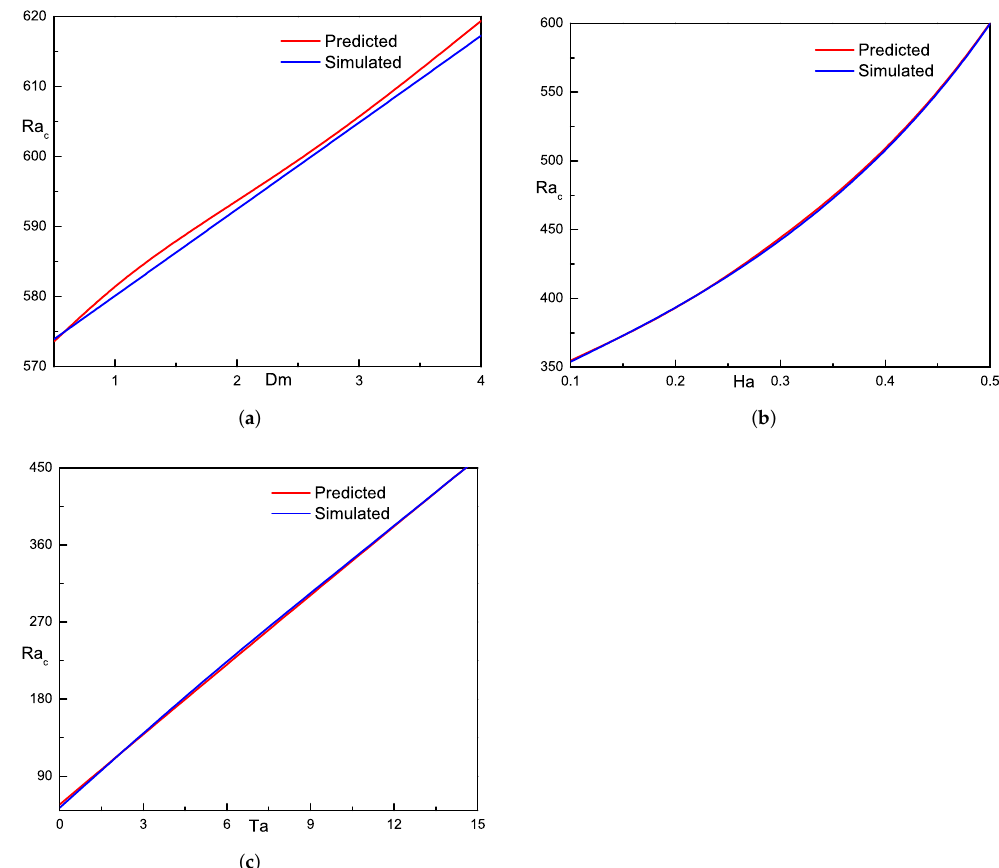
Figure 11. Comparison of the simulated and ANN-predicted critical Rayleigh number values for ( a ) Dm , ( b ) Ha , and ( c ) Ta